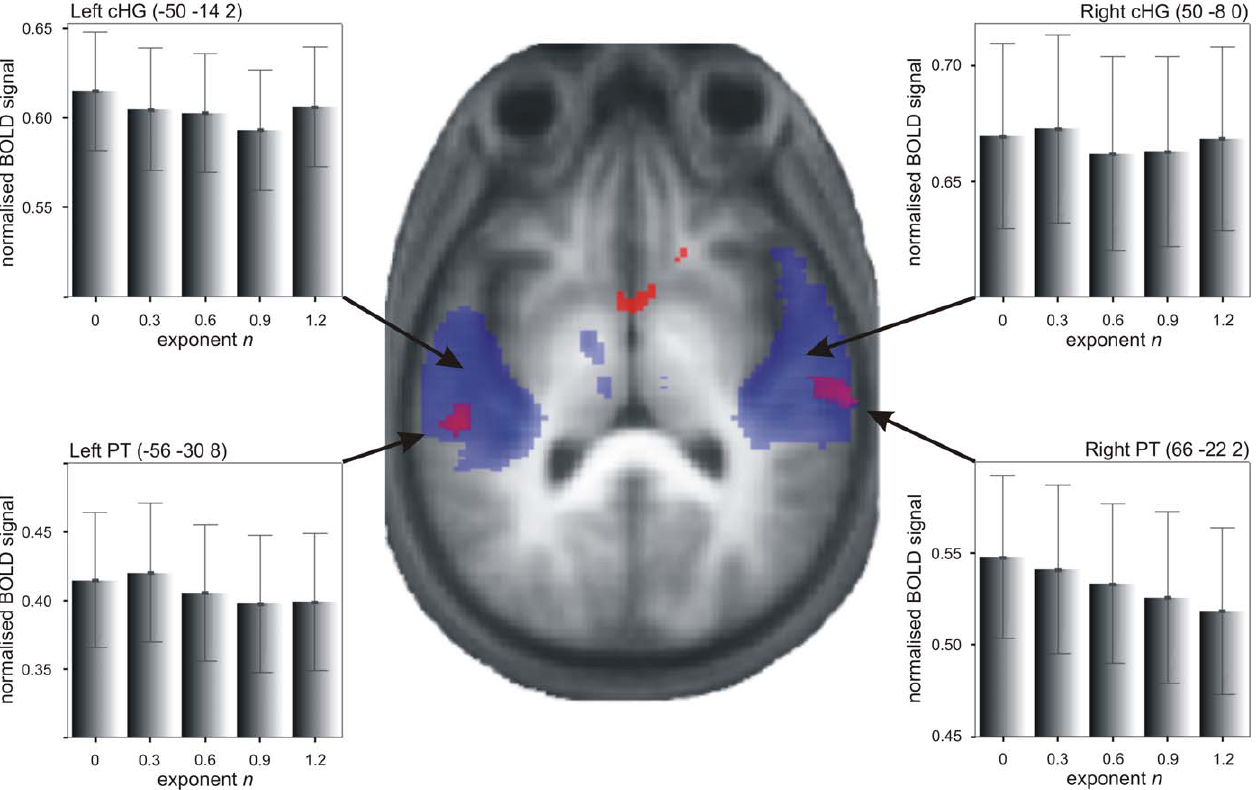
Figure 4. Study 2 Functional Imaging Data: Effect of Entropy Areas showing an increase in BOLD signal ( p , 0.005, uncorrected for multiple comparisons across the brain) as a function of increasing entropy (red) and areas that responded to sound in general ([sound–silence] contrast, blue) rendered on a tilted (pitch: (cid:2) 0.5) axial section of participants’ normalised average structural scan. Normalised mean percent BOLD signal change ( 6 SEM) at the local maxima in the left and right PT (bottom) and central HG (cHG, top) is plotted for the five levels of exponent n . See Figure S1 for corresponding plots of BOLD signal in medial and lateral HG.